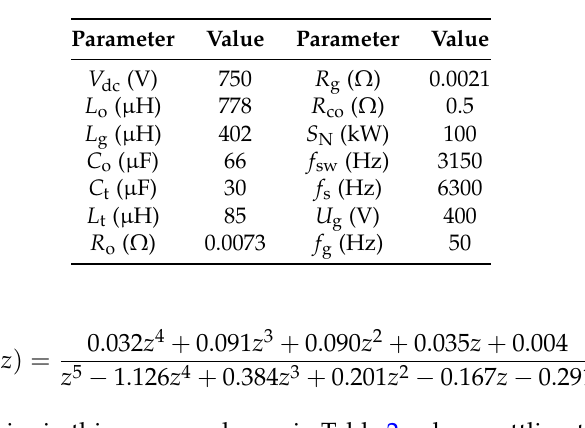
Table 1. Parameters of the 100-kW